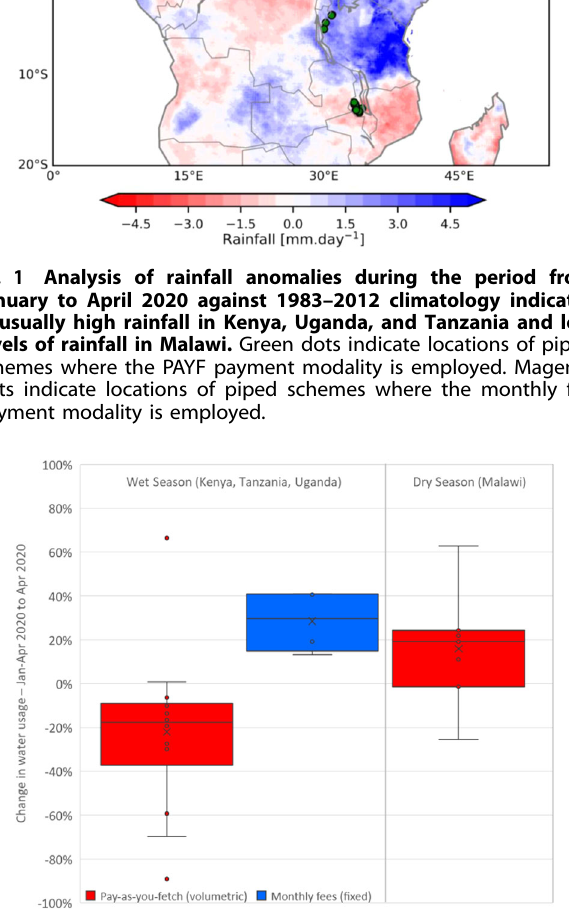
Fig. 2 Changes in water usage by payment modality and season in April 2020 compared to the period mean from January to April 2020. Where the PAYF payment modality is employed, increased rainfall and subsequent availability of alternative surface water sources during the wet season appears to buffer water demand from piped schemes. Box plot elements: mean marker, median centre line, upper and lower quartile box limits, 1.5× interquartile range whiskers, data